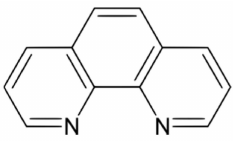
Figure 2. Molecular structure of 1,10-phenanthroline